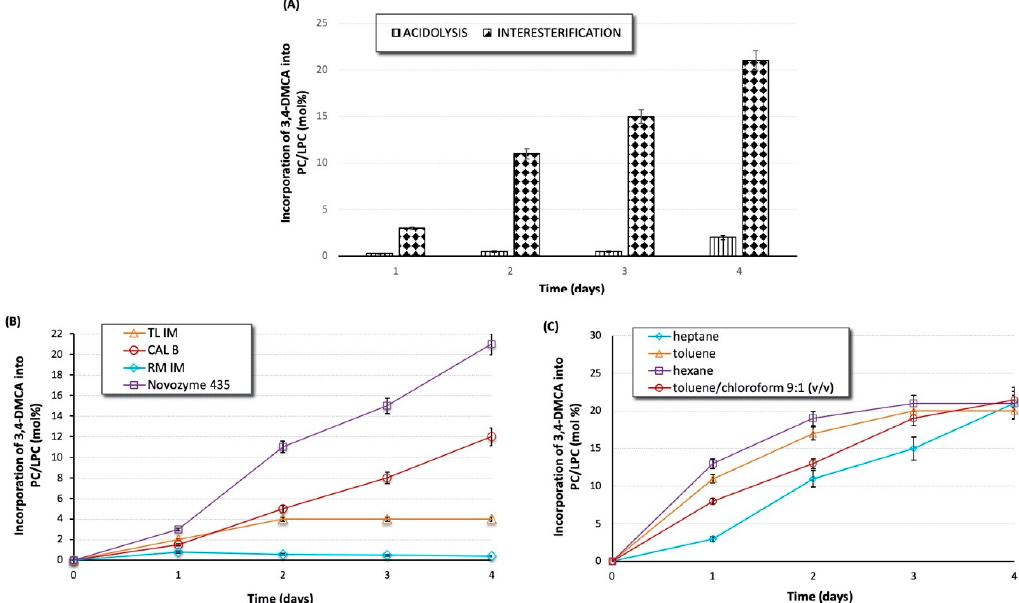
Figure 1. ( A ) Effect of different acyl donors on the incorporation of 3,4DMCA into egg-yolk phosphatidylcholine (PC). Reaction conditions: solvent, heptane; PC/acyl donor molar ratio, 1/10; lipase dosage, Novozym 435 30% (w/w); temperature, 50 °C; ( B ) time course of different lipase-catalyzed transesterification between egg-yolk phosphatidylcholine and 3,4-dimethoxycinnamic acid ethyl ester. Reaction conditions: heptane; PC/E3,4DMCA, 1/10; lipase dosage 30% (w/w); 50 °C; ( C ) effect of different organic solvent on the transesterification reaction of PC with E3,4DMCA. Reaction conditions: PC/E3,4DMCA, 1/10; Novozym 435 30% (w/w); 50 °C.